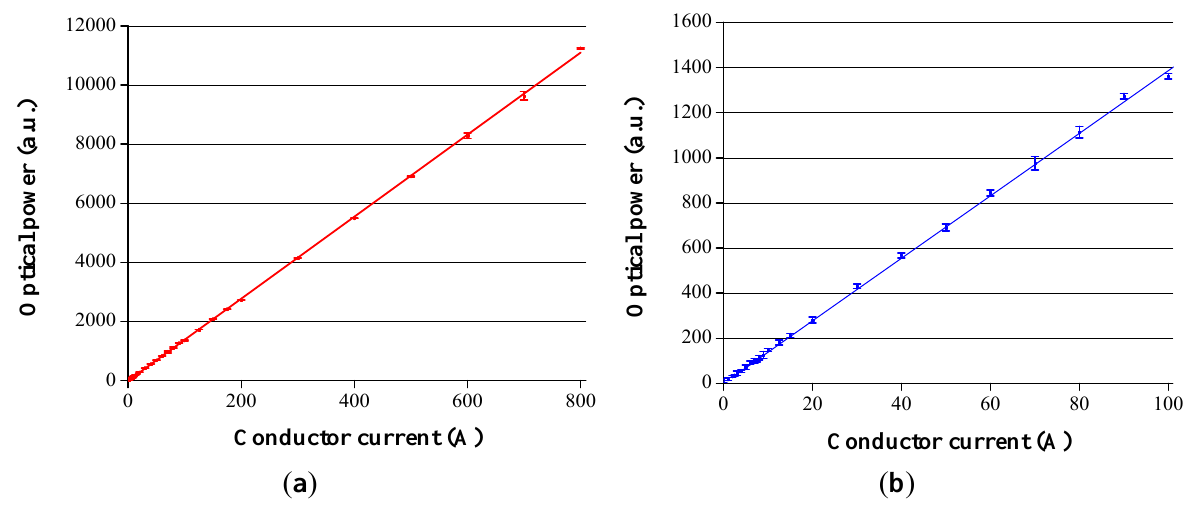
Figure 8. ( a ) 50 Hz component of the normalized DFT from I = 0 A to I = 800 A. ( b ) 50 Hz component of the normalized DFT from I = 0 A to I = 100